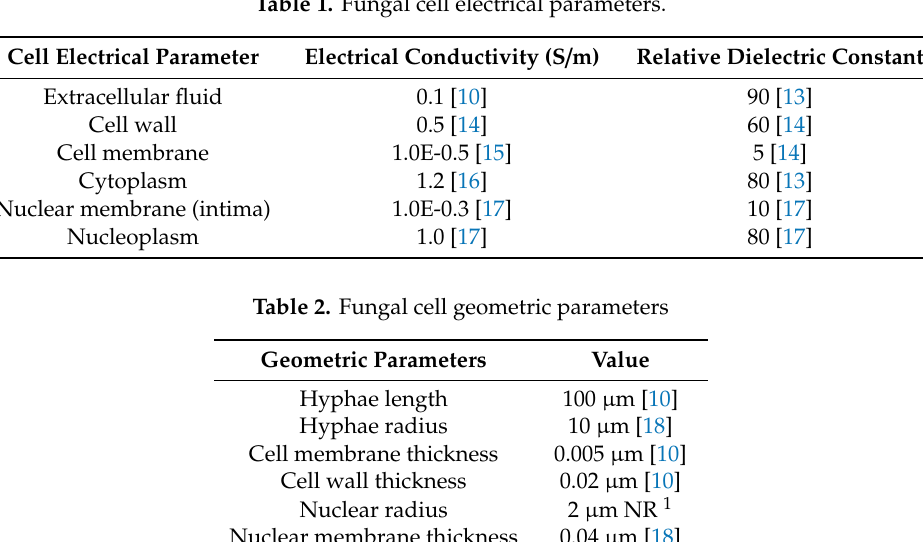
Table 1. Fungal cell electrical parameters.